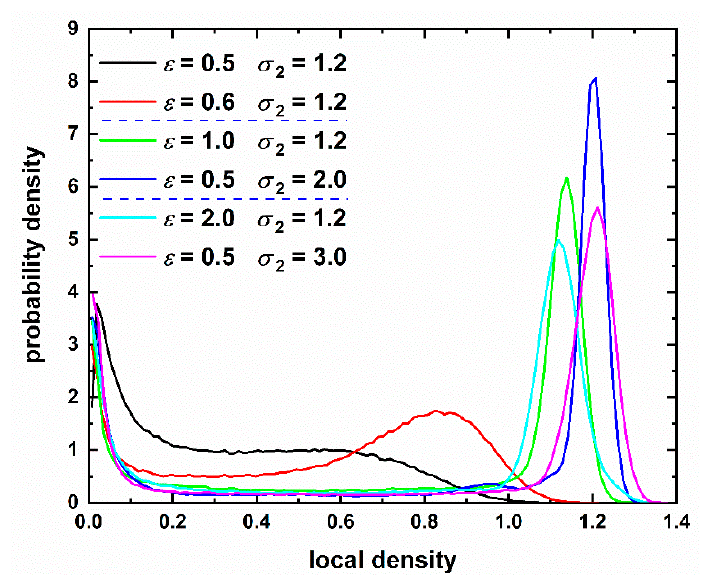
Figure 12. Distribution of local density for various pairs of intensity, ε , and range, σ , of the square well potential. Local density is calculated as the inverse of the volume of the Voronoi cell around each monomer. The corresponding final morphologies can be seen in Figure 7. Dashed horizontal blue lines in legend identify transitions to different phase regimes: amorphous → crystalline → glassy.